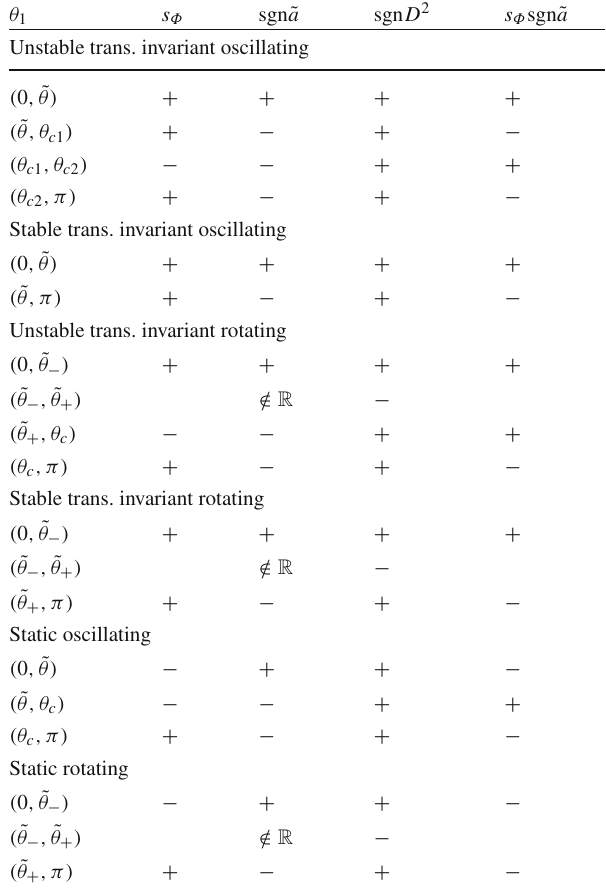
˜ a sgn D 2 s Φ sgn ˜ a